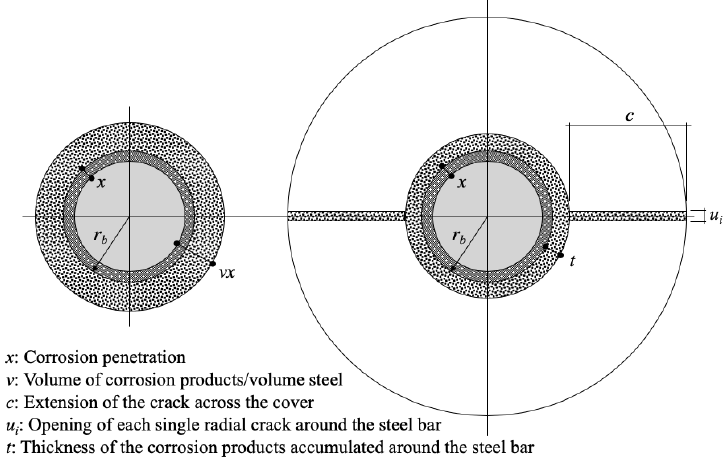
Figure 2. Schematic of the corrosion model for corrosion penetration and the corrosion products around the steel bar [47].